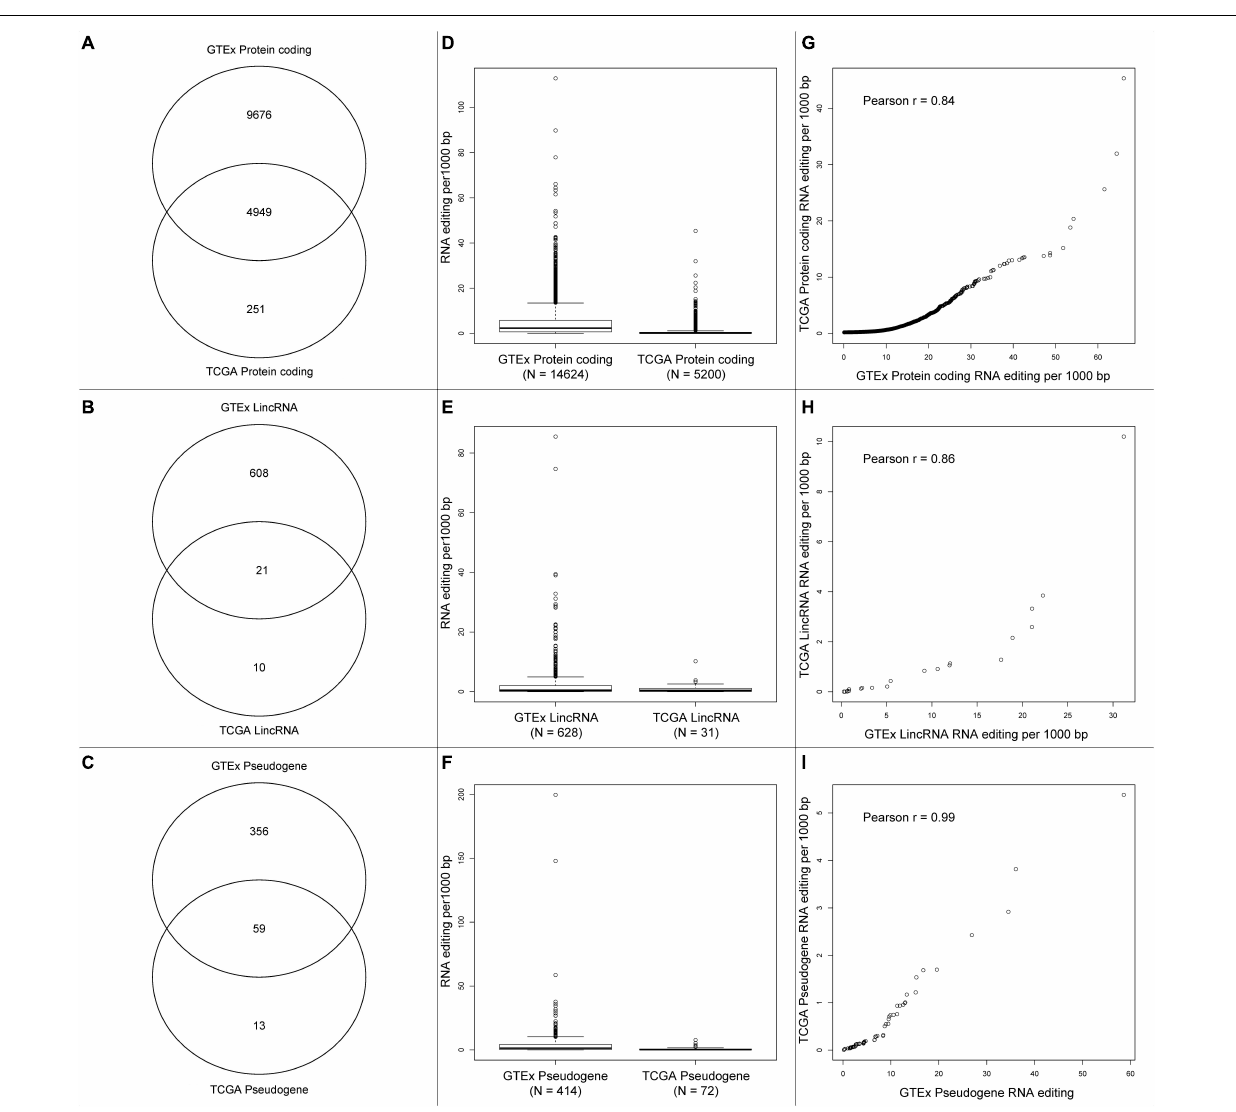
FIGURE 4 | (A–C) Venn diagrams of protein-coding genes, lincRNA and pseudogenes with RNA editing between GTEx and TCGA. (D–F) Boxplots of gene-level RNA editing rates of all protein-coding genes, lincRNA, and pseudogenes between GTEx and TCGA. (G–I) Scatter plots of gene-level RNA editing rates of the common protein-coding genes, lincRNA, and pseudogenes between GTEx and TCGA.